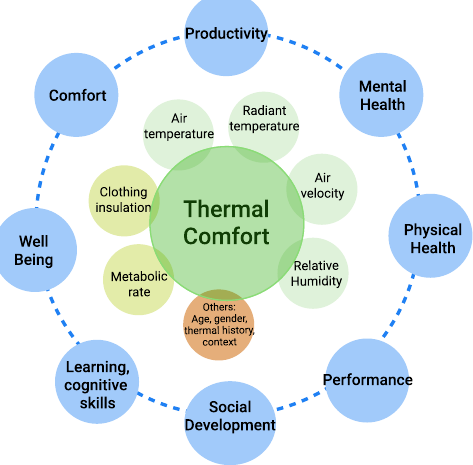
Figure 1. Thermal comfort factors and their